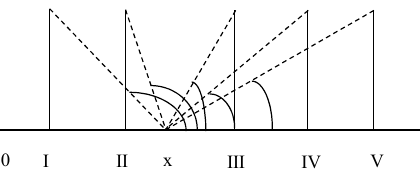
Figure 1. The measurement schematic map.